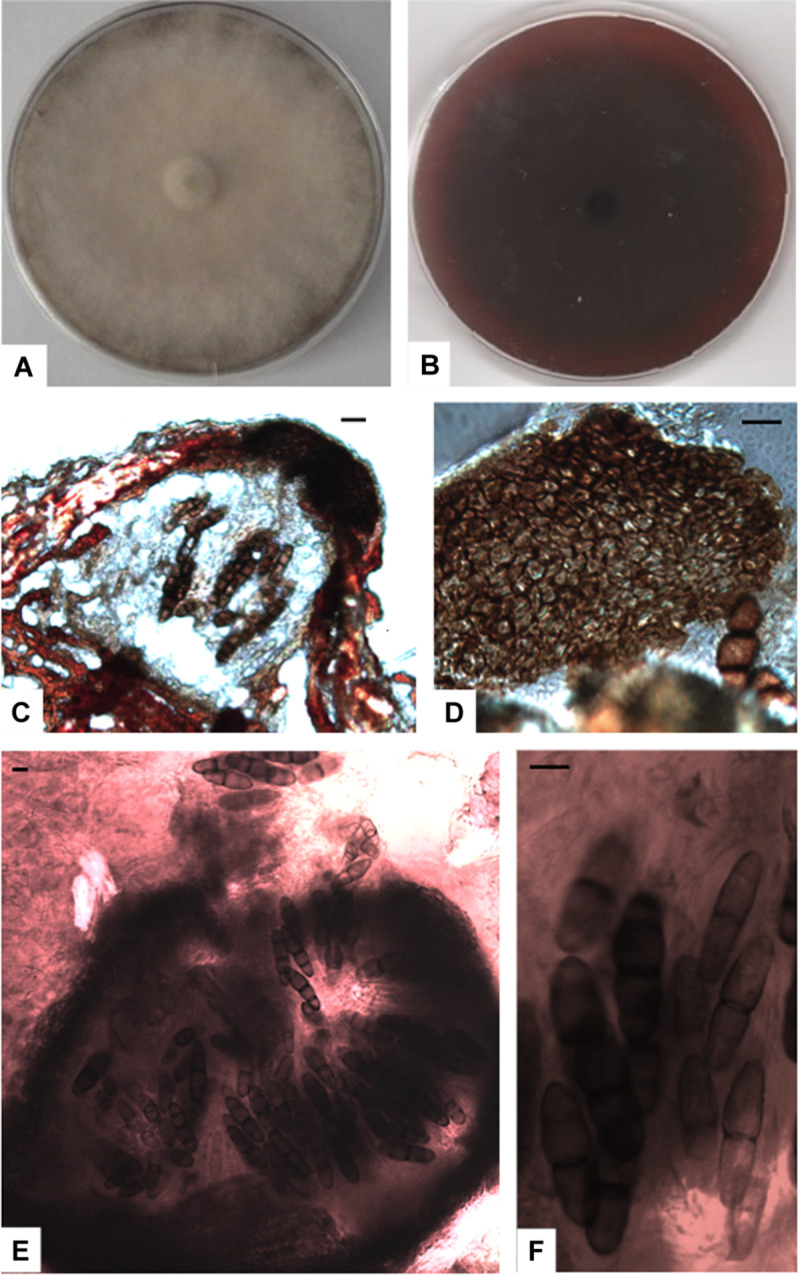
Paralulworthia gigaspora sp.nov. 28-days-old colony incubated at 21°C on MEASW (A) and reverse (B); ascomata (C,E), peridium with textura angularis (D); asci with eight ascospores at different degrees of maturity (F). Scale bars 20 μm.